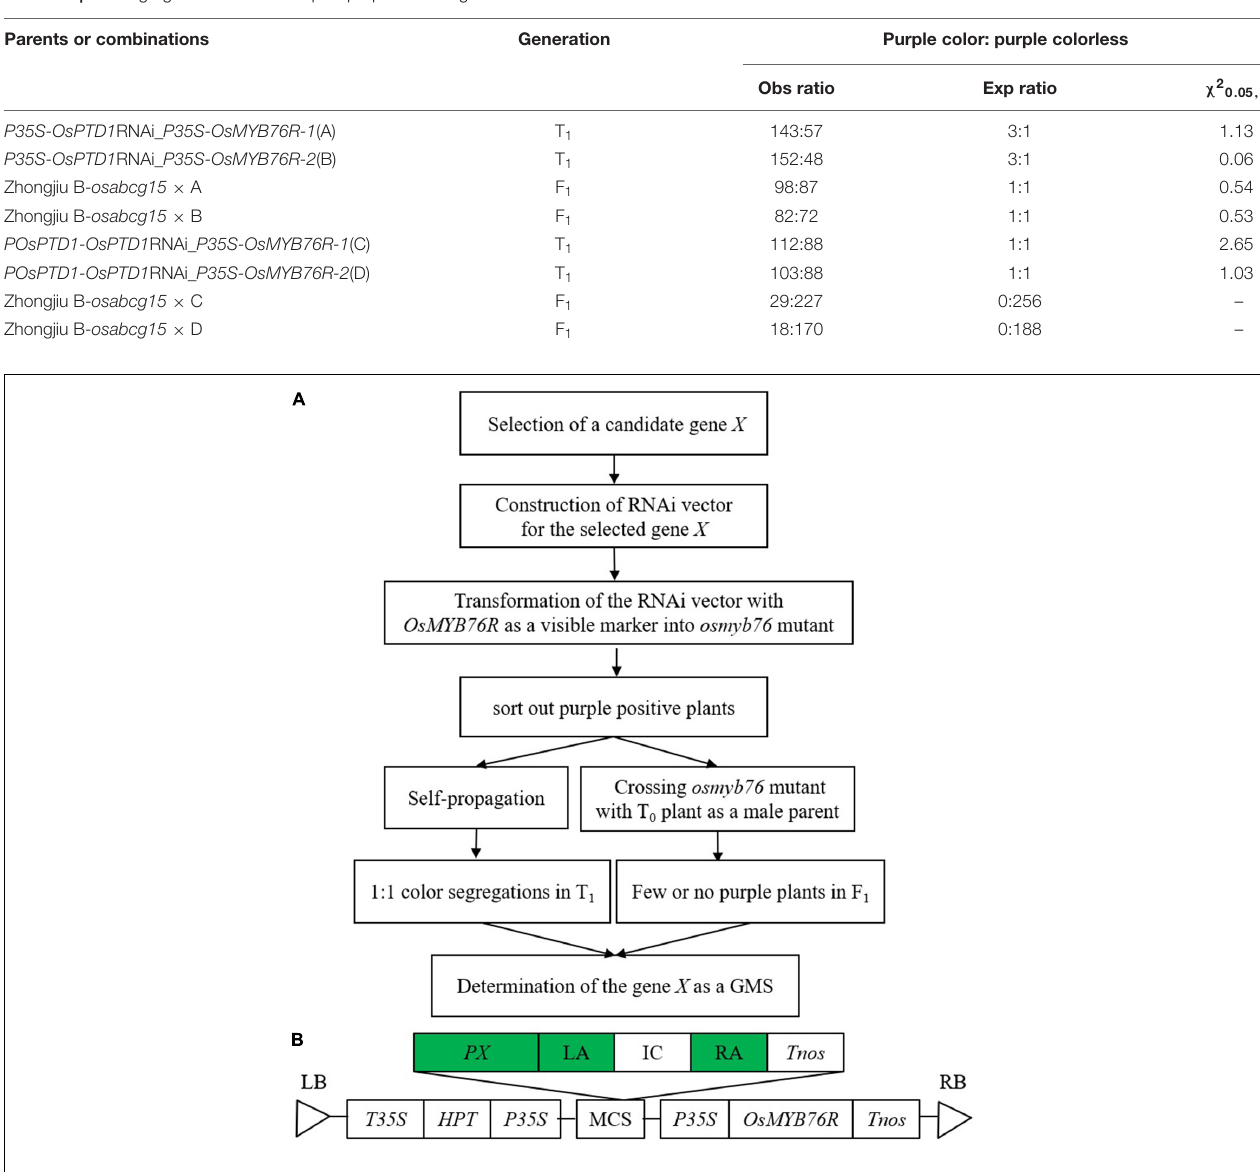
FIGURE 4 | Strategy for gametophytic male sterility preparation and identification. (A) Schematic diagram of gametophytic male sterility (GMS) preparation and identification. (B) Vector structure of this strategy. When this strategy is used, the green highlighting should be replaced according to the candidate GMS-related gene. X, GMS candidate; P X , promoter of X ; LA, left arm of RNAi- X ; IC, the first intron of OsC1 ; RA, right arm of RNAi- X .